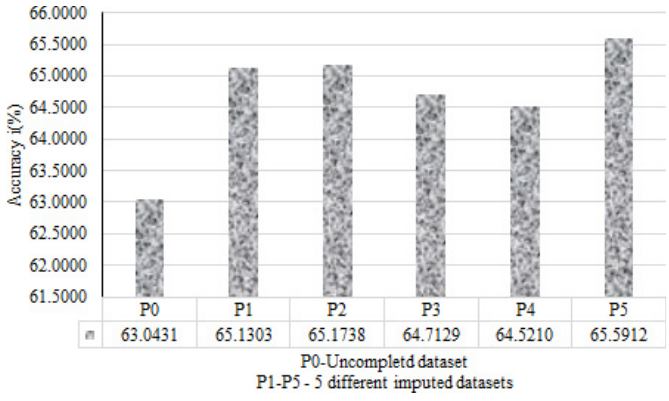
Fig. 4. ELM validation of multiple imputations technique upon Pima Indians Diabetes dataset showing that the results of classi¯cation of imputed datasets ( P 1 – P 5) are more accurate than the incomplete dataset ( P